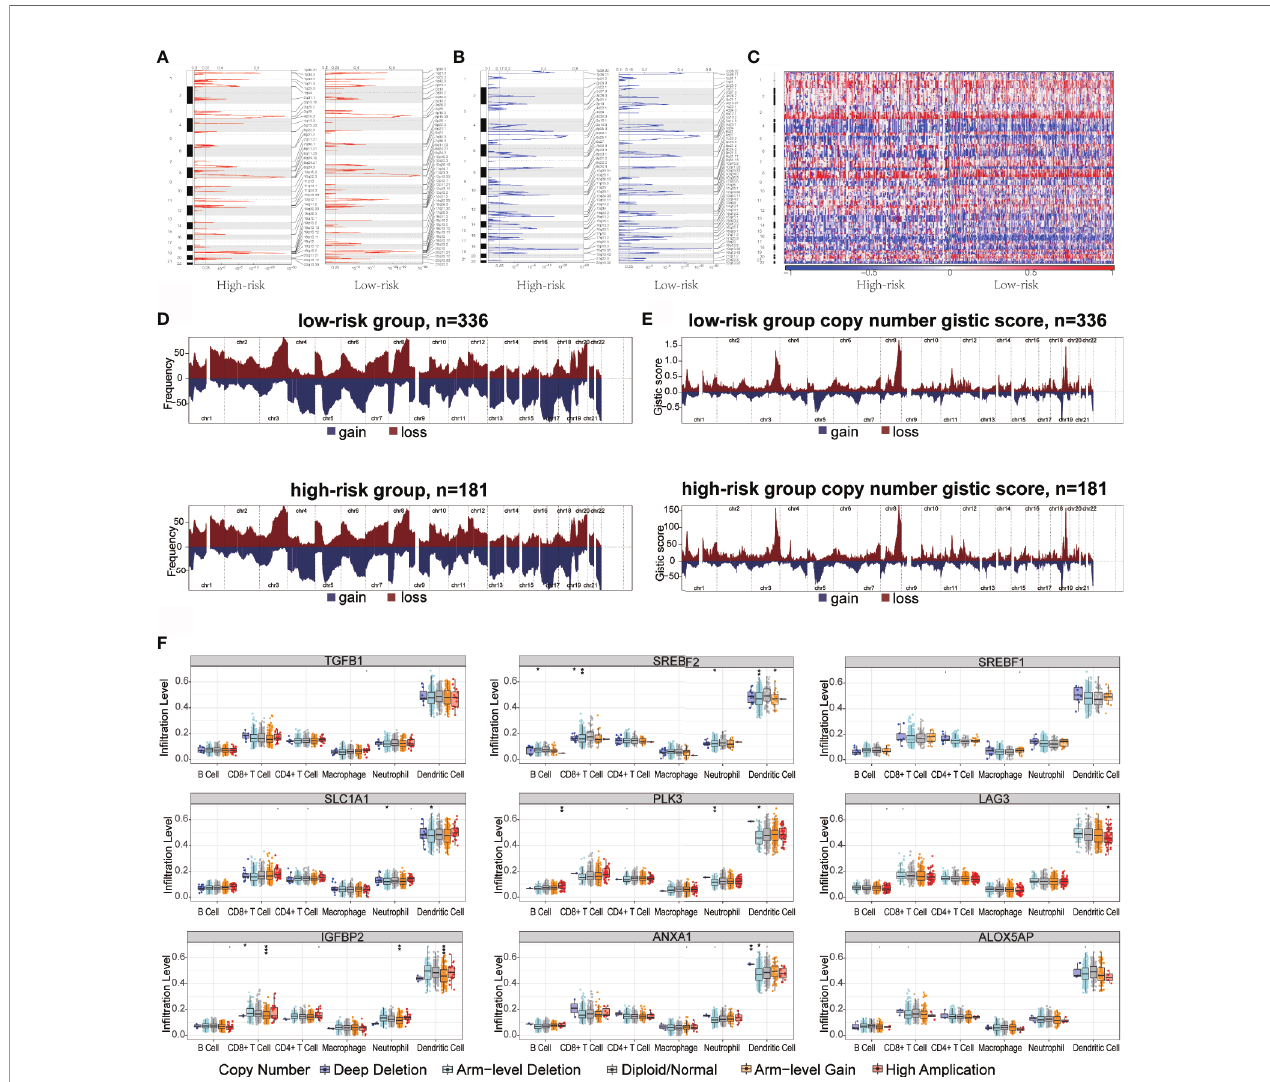
FIGURE 5 | Copy number variation in high- and low-risk groups immune in fi ltration in ovarian cancer. (A, B) Copy number pro fi les for high- and low-risk groups, with gains in dark red and losses in midnight blue. Gene segments are placed according to their location on chromosomes, ranging from chromosome 1 to chromosome 22. (C) Heat map of the differences in copy numbers in 22 chromosome between the high- and low-risk groups. (D, E) The left plot (D) illustrates the frequency of the gains and losses. The right plot (E) shows the cytoband with focal ampli fi cation and focal deletion generated using the GISTIC_2.0 software. The q value of each locus is plotted horizontally. (F) Effect of genetic alterations on hypoxic signatures of immune cell in fi ltration. *P < 0.05, **P < 0.01, ***P <